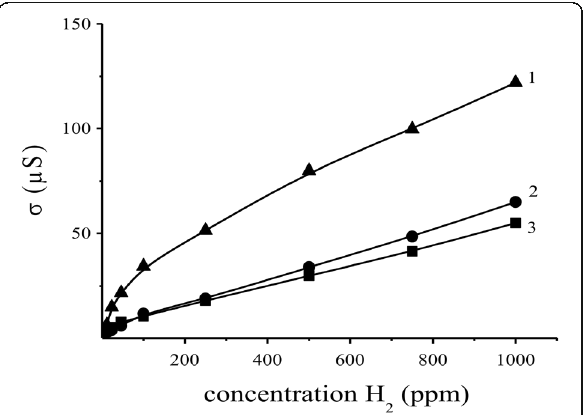
Fig. 6 Dependence of the conductivity of the sensor S 2 based on 0.09% Pd/SnO 2 nanomaterial on the hydrogen concentration at different sensor temperatures: 1 261 °C, 2 327 °C, 3 382